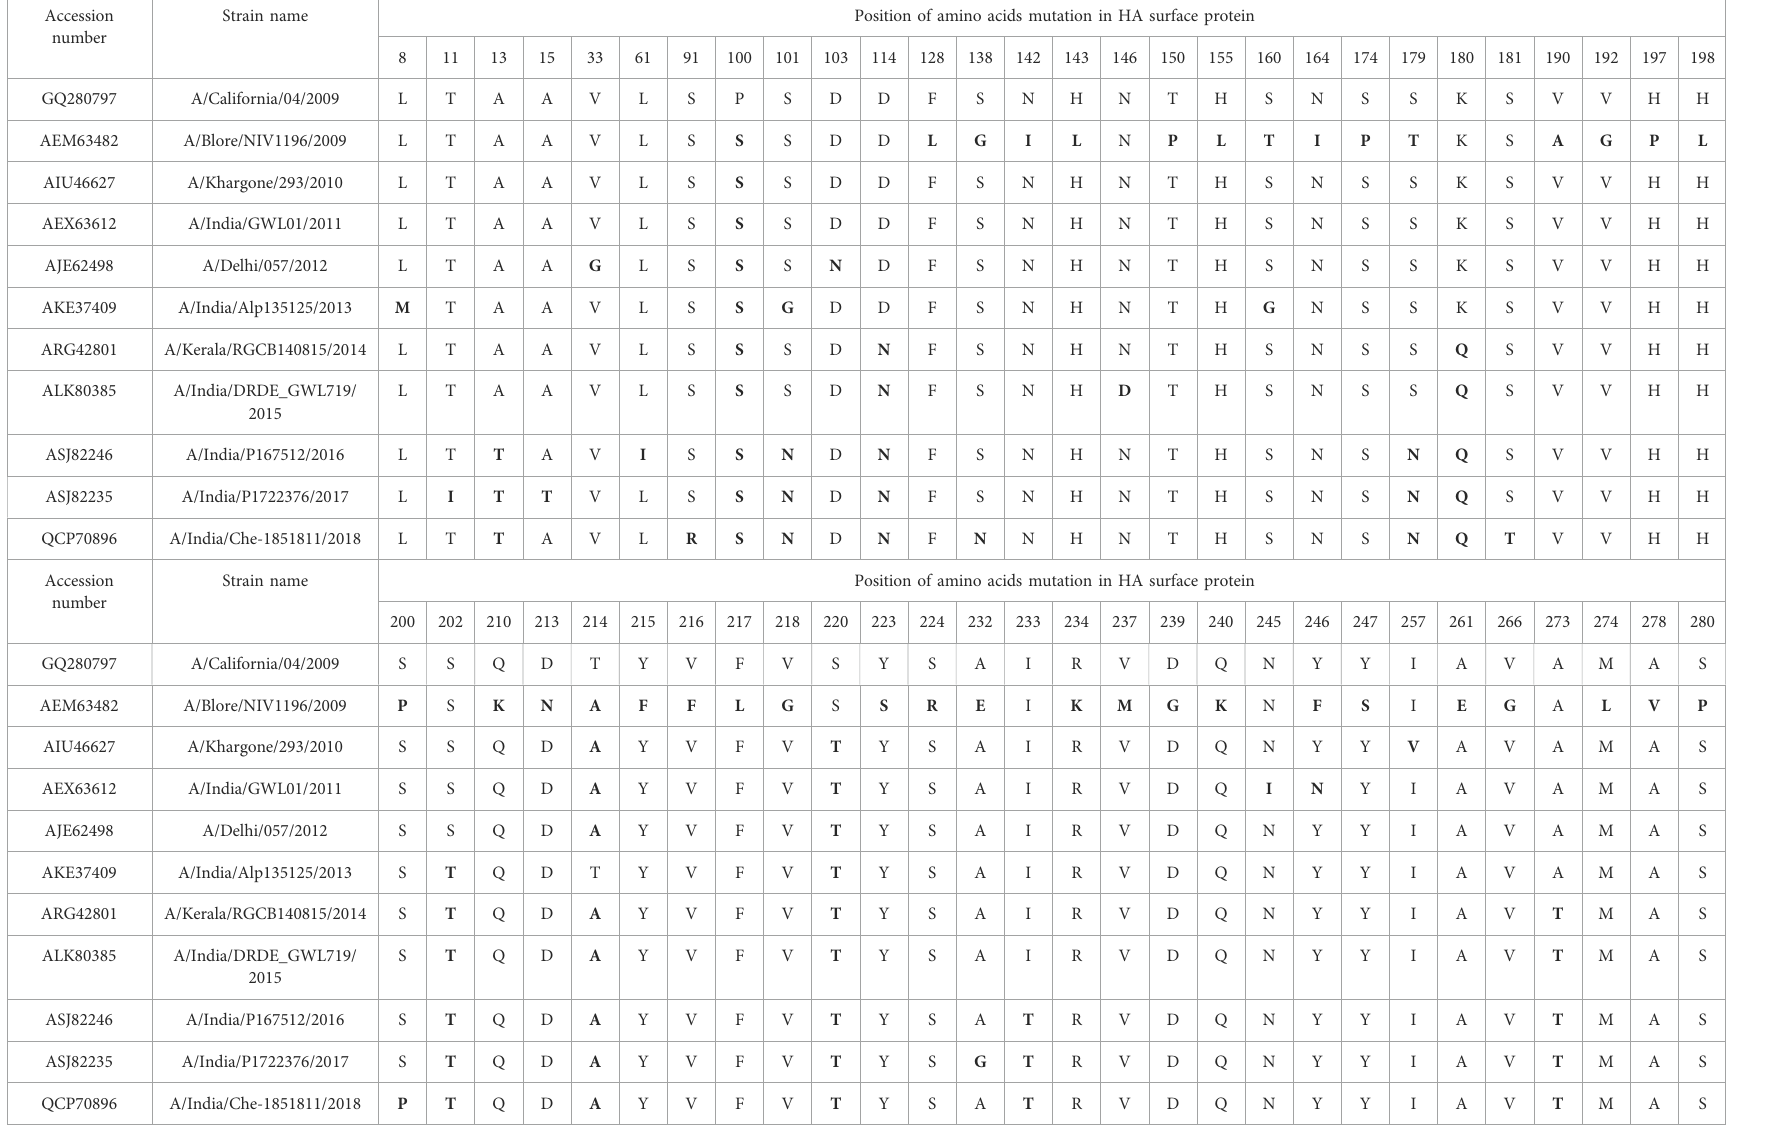
TABLE 3 Mutations (bold fonts) in the HA Ind proteins reported during 2009-2018 are compared with the HA Cal protein (2009) and are highlighted in